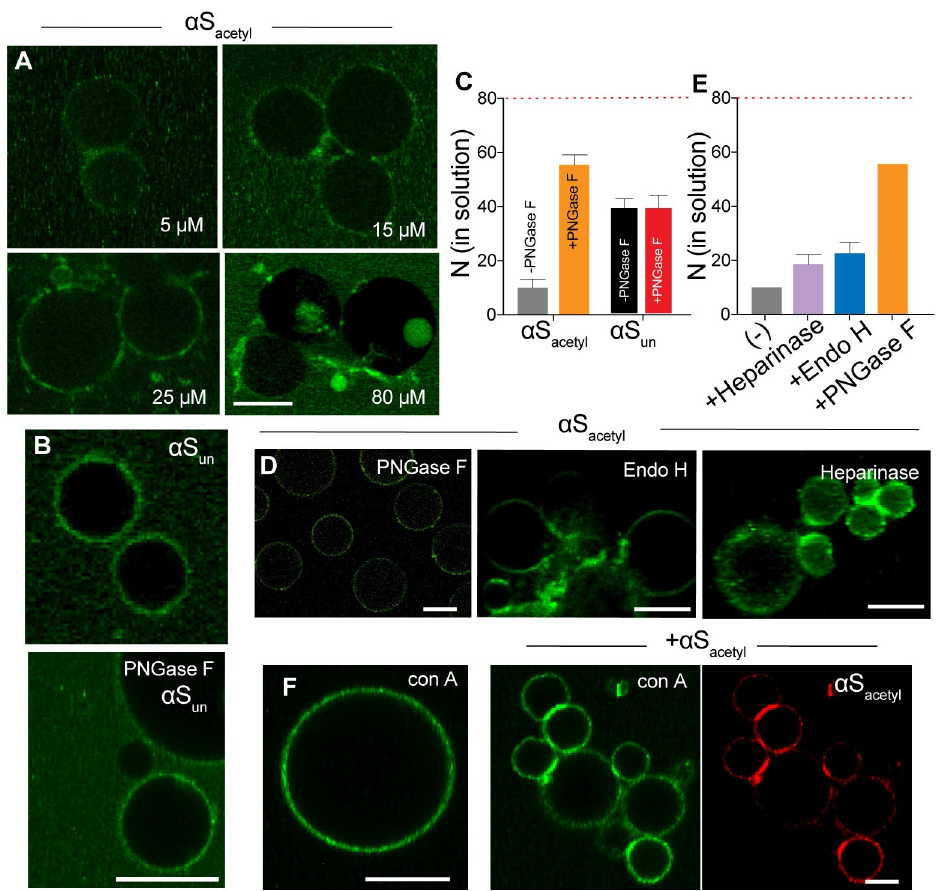
Fig 4. Removal of N-linked glycans disrupts binding of α S acetyl to SH-SY5Y proteoliposomes. (A) Images of SH-SY5Y GPMVs incubated with 100 nM α S acetyl -AL488 and unlabeled α S acetyl (concentrations indicated). (B) Upper: as in (A) but with 100 nM α S un -AL488 and 80 μ M unlabeled α S un . Lower: as in upper panel but with treatment with PNGase F. (C) Binding of 80 nM α S acetyl -AL488 or α S un -AL488 to GPMVs quantified by FCS as loss of protein ( N , number of molecules) from solution. The number of molecules in control wells lacking GPMVs is indicated by the red- dashed line. (D) Representative images of SH-SY5Y GPMVs incubated with 100 nM α S acetyl -AL488 and 80 μ M unlabeled α S acetyl after treatment of GPMVs with the indicated endoglycosidase. (E) Binding of α S acetyl -AL488 to Heparinase- and Endo H-treated SH-SY5Y GPMVs measured by FCS, as in panel C. Binding +/ − PNGase F from panel C shown for comparison. (F) GPMVs incubated with 50 nM conA-AL488 in the absence and presence of 100 nM α S acetyl -AL594 and 80 μ Mof unlabeled α S acetyl . The data are presented as mean ± SD, n = 3. Scale bars = 10 μ m.The underlying data for this figure can be found in S1 Data. α S, α -Synuclein; α S acetyl , N-terminally acetylated α S; α S un , unmodified α S; AL488, Alexa Fluor 488; Endo H, endoglycosidase H; FCS, fluorescence correlation spectroscopy; GPMV, giant plasma membrane vesicle; PNGase F, peptide-N-glycosidase F; SH-SY5Y, human neuroblastoma; conA-AL488, AL488-labeled conA. binding affinity for α S and α S . Binding of monomer α S to GPMVs was quantified by acetyl un